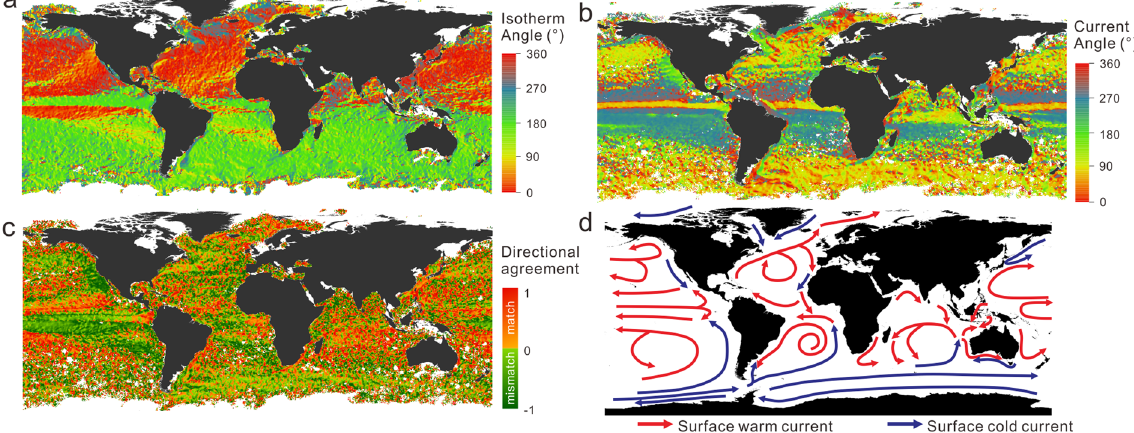
Figure 2. Angles and resulting directional agreement between ocean surface currents and sea surface temperature gradients. Vector angles associated to ( a ) sea surface temperature gradients and ( b ) annual mean eastward and northward current flow speed components retrieved from ocean satellite-tracked drifter data (1979–2012). ( c ) The directional agreement between both parameters estimated as the cosine of the angle difference. ( d ) A non-exhaustive schematic of major surface current systems is provided for comparison. Note how prevailing northward-flowing currents in the Northern Hemisphere and southward-flowing currents in the Southern Hemisphere (e.g., Kuroshio and Brazil currents) are dominated by red colours denoting good directional agreement, whereas green colours predominate for southward flowing currents in the Northern Hemisphere and for northern flowing currents in the Southern Hemisphere (e.g., California and Humboldt currents), denoting directional mismatching. This figure was generated using ArcGIS 10.2 (ESRI, Redland, CA; www.esri.com) and R 3.2.3 (http://www.R-project.org).